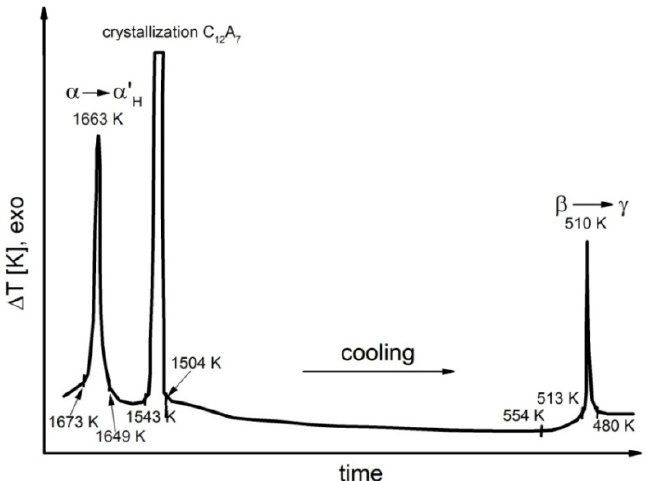
Figure 7. Thermogram recorded for sample 4 during the cooling process.